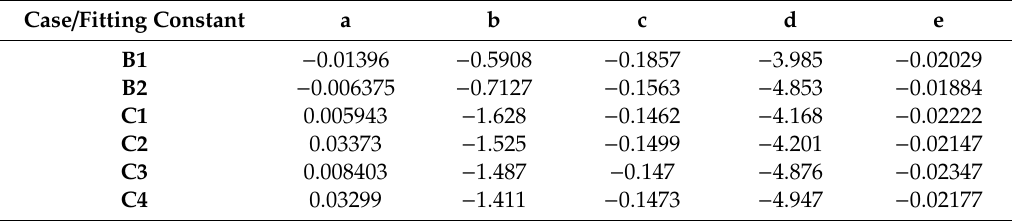
Figure 6. ∆𝑻 𝑪𝑯𝒙 profiles for Celcor based material combinations of multi-layered stack ( a ) calculated ( b ) steady state extrapolation. Table 5. Fitting constants for exponential extrapolation of various material combinations of multi layered stacks.